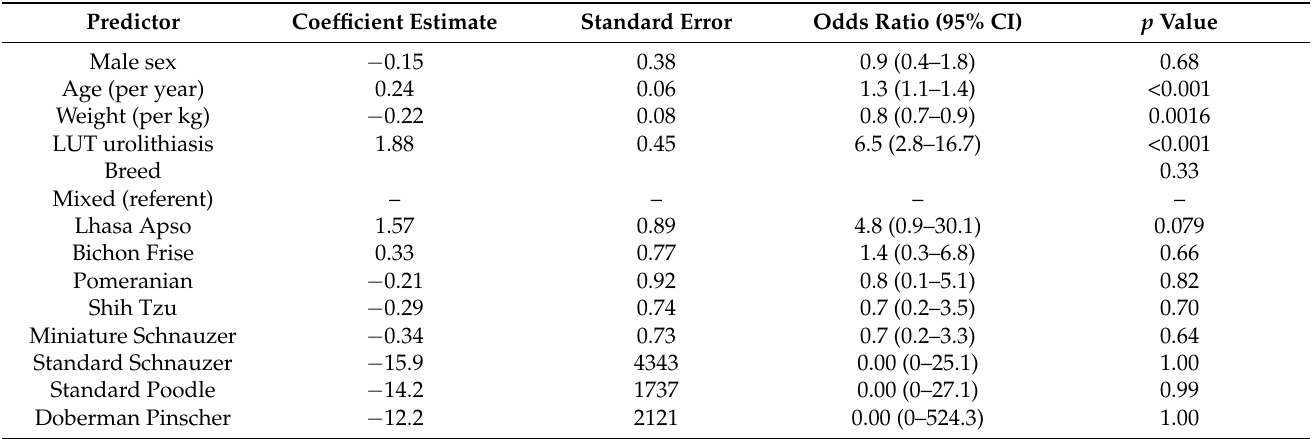
(Table 3). Increasing age, decreasing weight, and active or historic LUT urolithiasis were predictors of UUT urolithiasis. The breed was not identified as a predictor of UUT urolith risk in the regression analysis. Table 3. Multivariable regression analysis of predictors of radiographically apparent upper urinary tract urolithiasis in 319 dogs, including 68 mixed breed dogs and 251 dogs of breeds reported to have increased risk for calcium oxalate (CaOx)